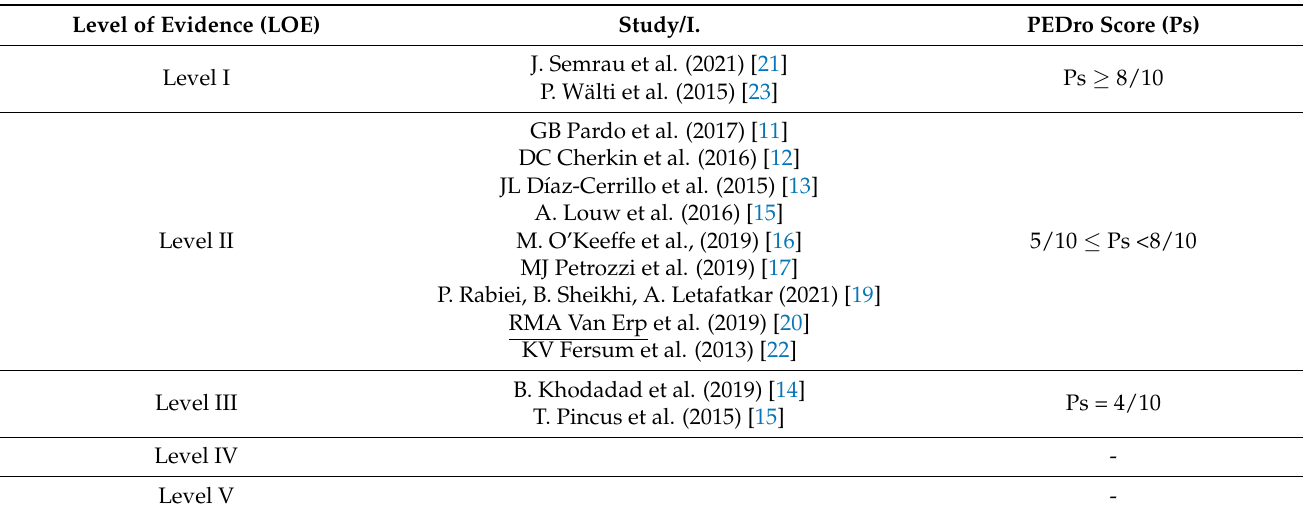
Table 4. Level of evidence of the included